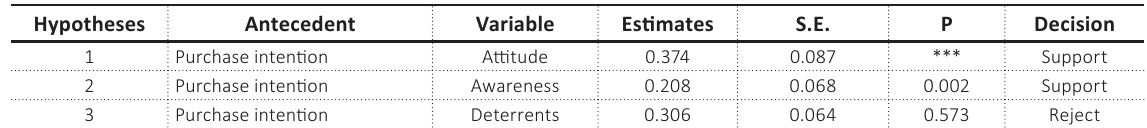
Table 4. Relation among the